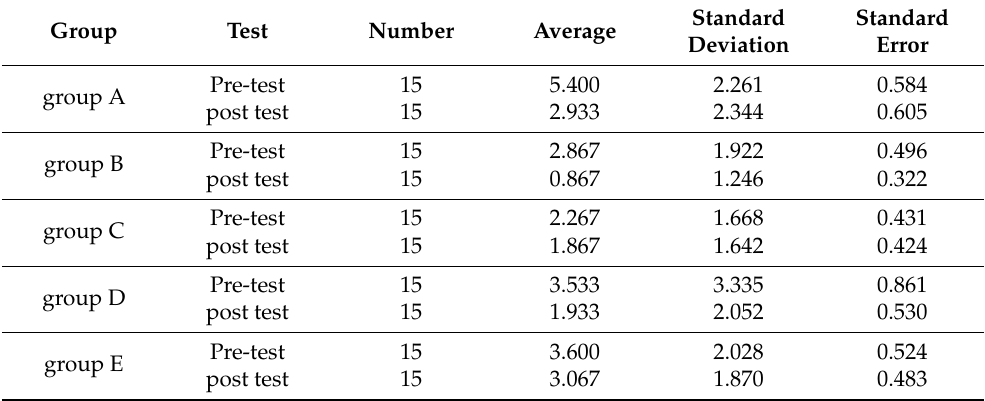
Table 4. Summary table of pre- and post-test mean and standard deviation of “stress” for middle-aged and elderly people in the same